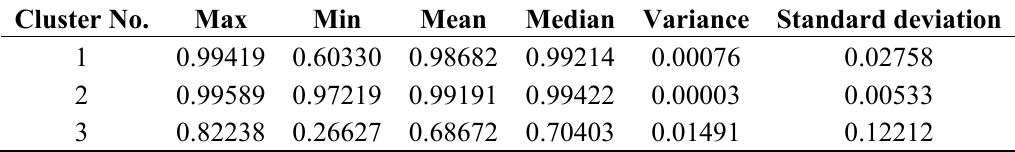
Figure 8. Silhouette coefficient value for different clusters. Table 1. Statistical features of the silhouette coefficient values for each clusters.